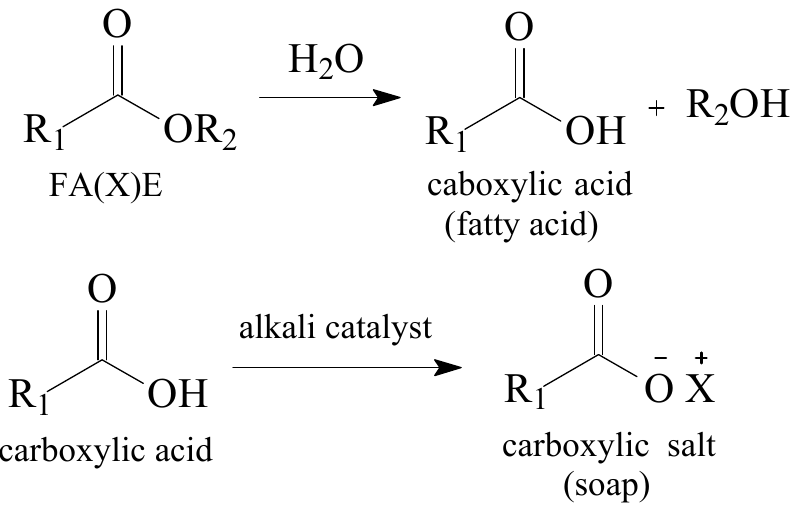
Figure 3. Hydrolysis reaction of FA(X)E and saponification of carboxylic acid in alkali medium. Kinetics of transesterification reaction is favored in alkali medium, being approxi- mately four-thousand times faster than acidic catalysis, which is also one of the reasons for its application at industrial scale. Consequently, the same yield conversion can be achieved in acidic catalysis with significantly longer reaction times [23,30,31]. Table 4 presents the main characteristics of alkali and acidic mediums for transesterification reaction of TAG’s to FA(X)E. Table 4. Main characteristics of the alkali and acid catalysis for biodiesel